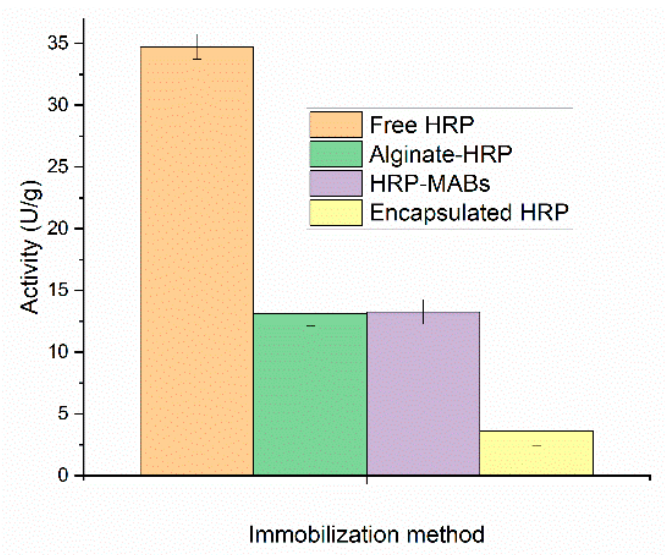
Figure 7. Effect of the immobilization method on free and immobilized HRP activity. The activity was determined using the standard method with substrate pyrogallol and H 2 O 2 .